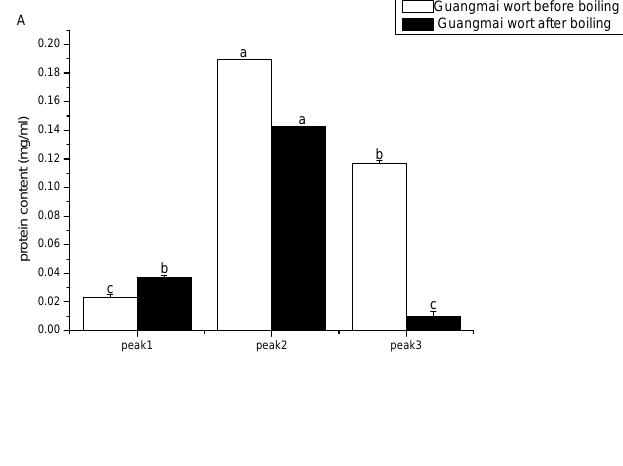
Figure 7 . Protein contents of the peaks I, II and III from Guangmai (A) and Baudin (B) worts before and after